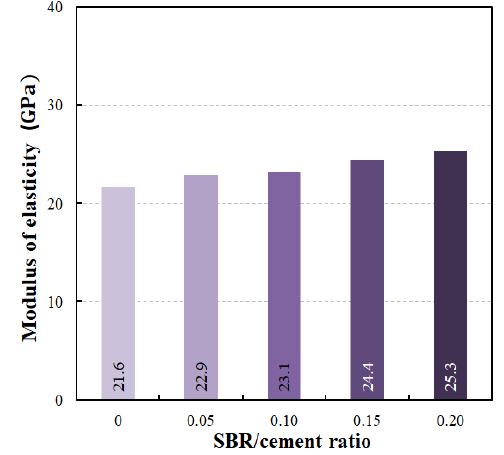
Figure 5. Moduli of elasticity for different SBR/cement ratios.